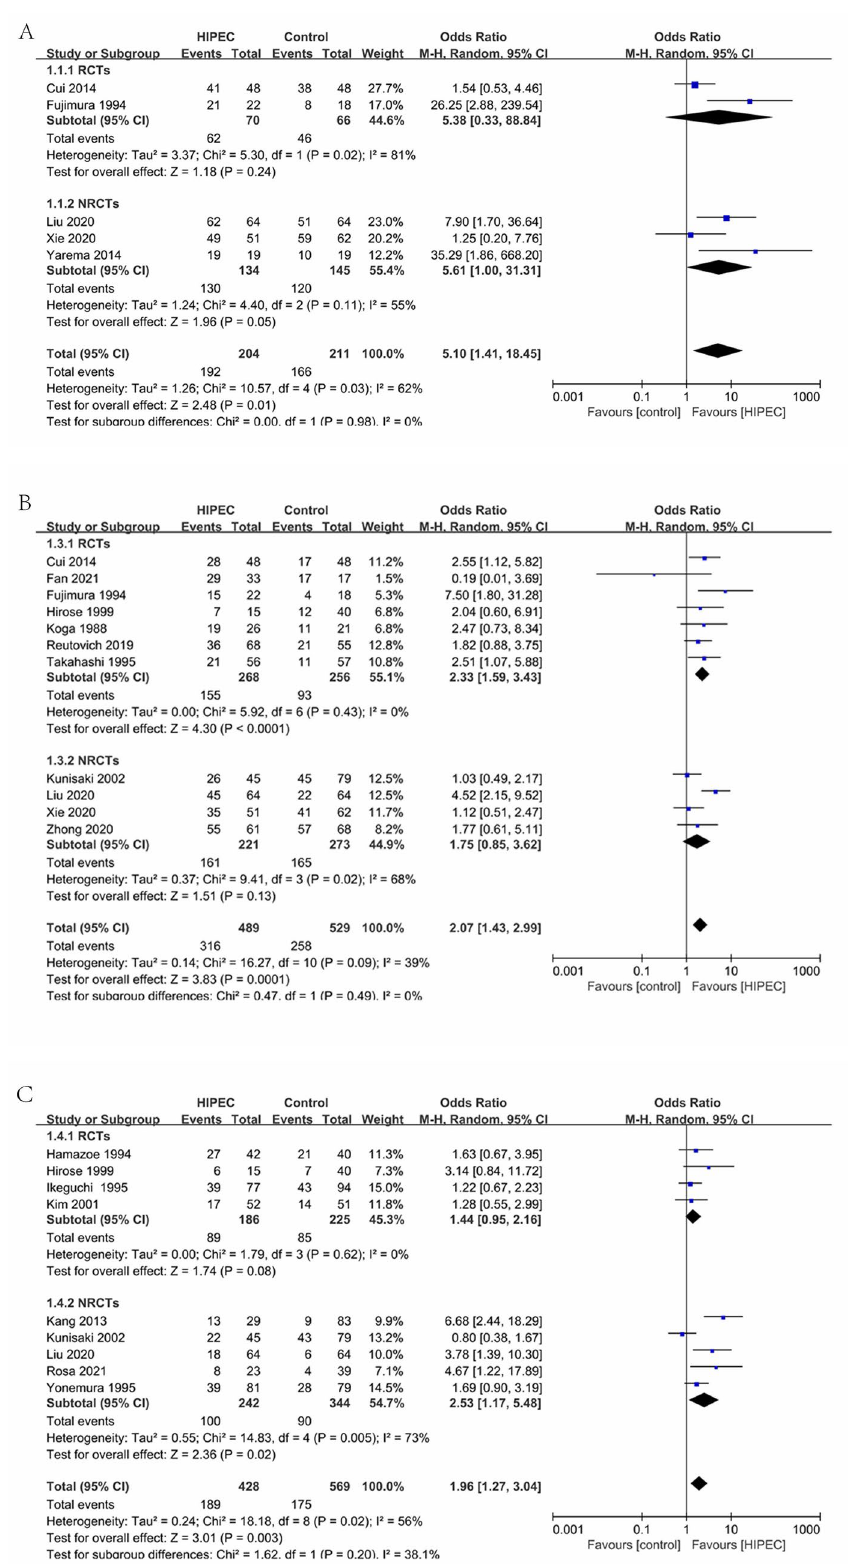
Figure 5. Overall 1-year survival ( A ), Overall 3-year survival ( B ), Overall 5-year survival ( C